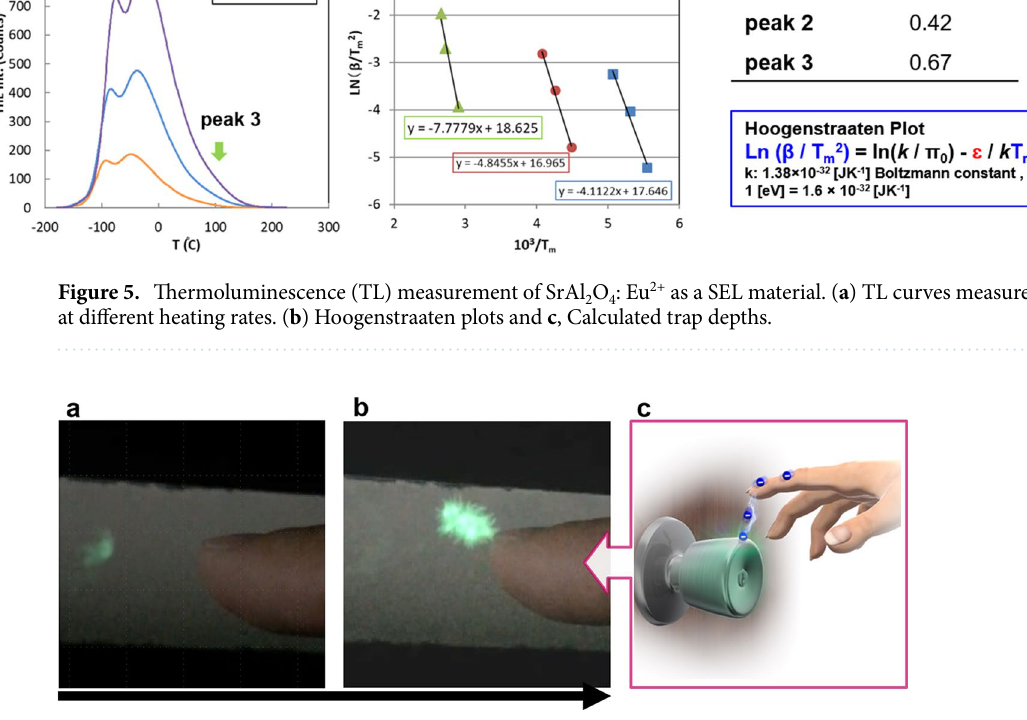
Figure 6. Static electricity induced luminescence ( a , b ) Before and just as a ‘spark’ is observed by electrostatic discharge through a charged finger. ( c ) Image illustrating electrostatic discharge generated by the